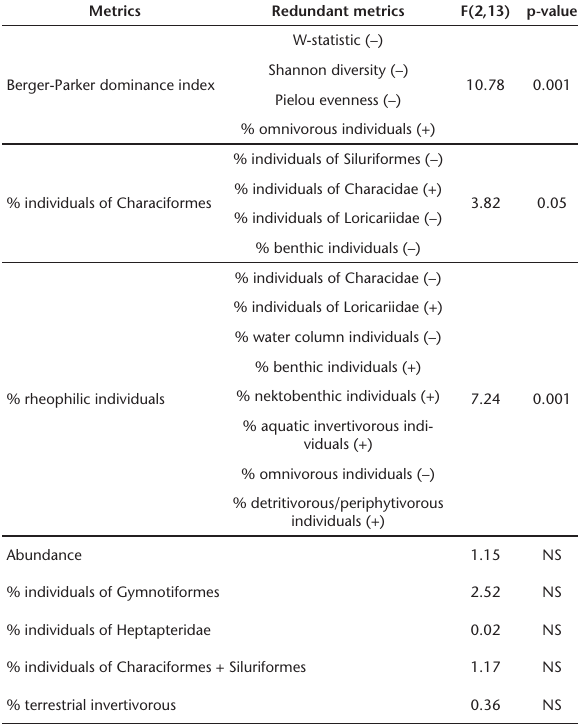
Table 2. Performance of the metrics in distinguishing streams accord- ing to their conservation status, with the corresponding F statistic and p-value. For each sensitive metric, the redundant metrics (R > |0.75|) are shown. (+) positive correlation with the sensitive metric; (–) negative correlation with the sensitive metric.